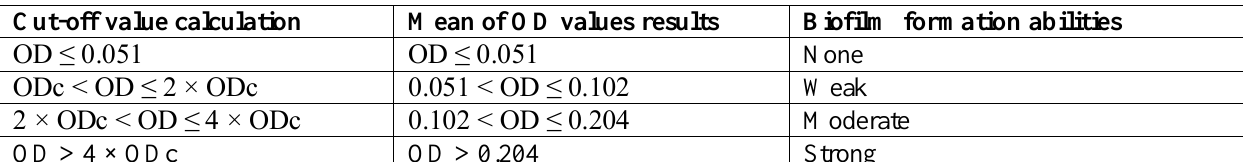
Table 2: Classify biofilm formation ability through the use of a microtiter titer plate [32].